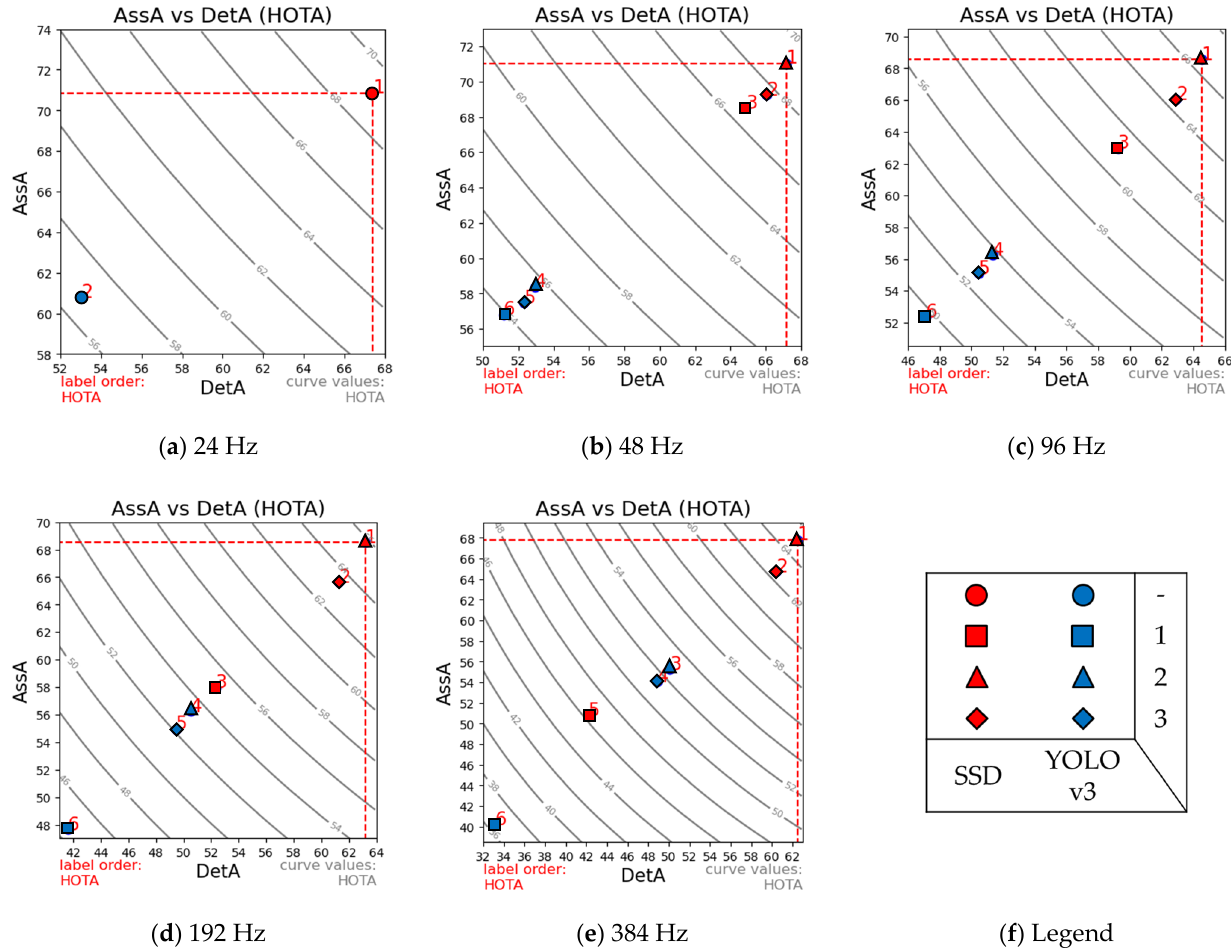
Figure 10. Comparison between the results of the different tracking configurations for various tem- poral resolutions. AssA is plotted against DetA with the resulting HOTA values marked for tracker configuration, for temporal resolutions of ( a – e ) 24 Hz–384 Hz. The legend ( f ) defines the symbols used according to the object detector used and tracking mode. Results show a linear correlation between the AssA and DetA, with Mode 2 (cid:48) s approach outperforming the other configurations for either object